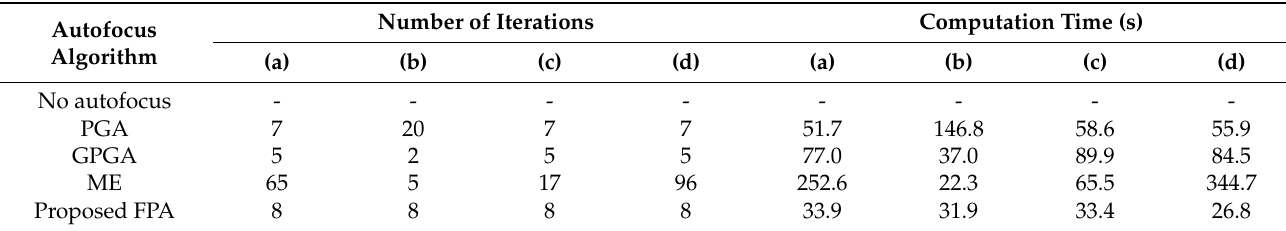
Table 3. Comparison of the number of iterations and computation time for different autofocus